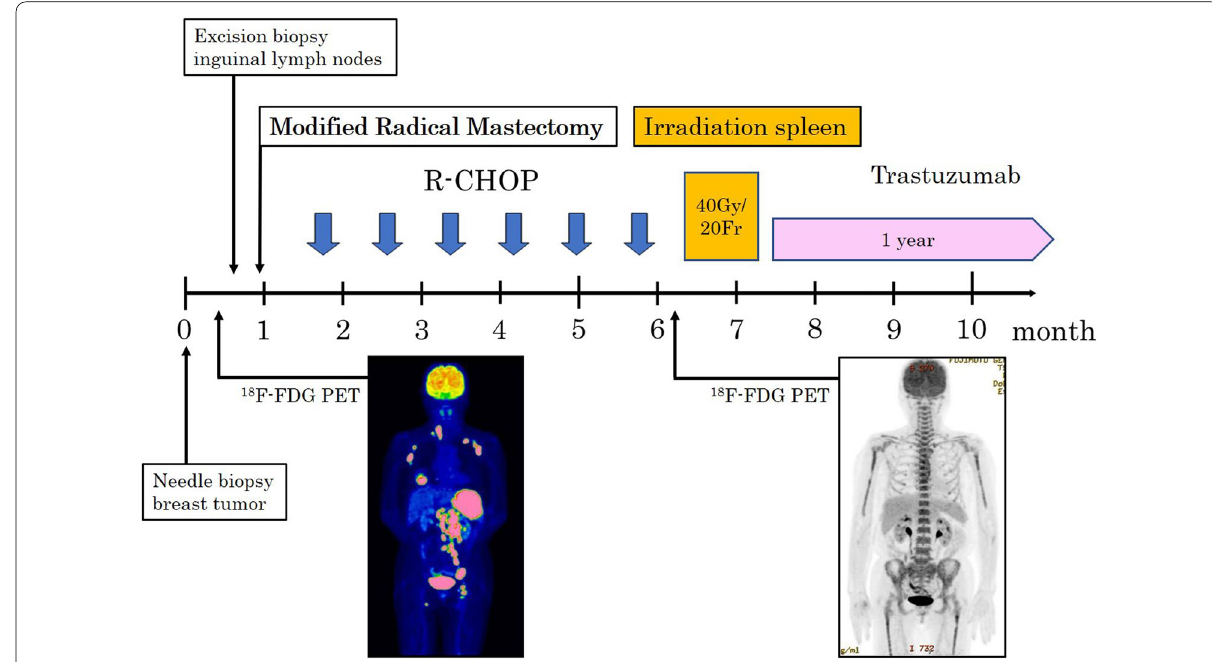
Fig. 5 Treatment progress chart. After the completion of six courses of R-CHOP, PET–CT showed no lymphoma lesions or new